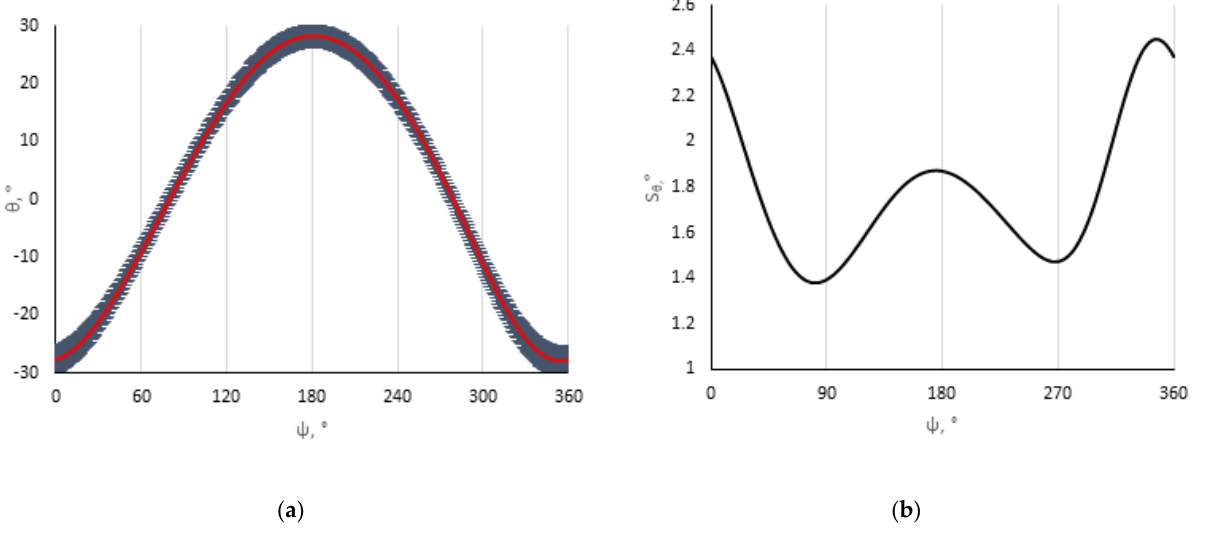
Figure 10 . Curve illustrating : ( a ) values of composite quantity θ , together with standard measuring uncertainty due to the measurement of e , L , d , ε . ( b ) standard measuring uncertainty values for composite quantity θ due to the measurement of e , L , d , ε .